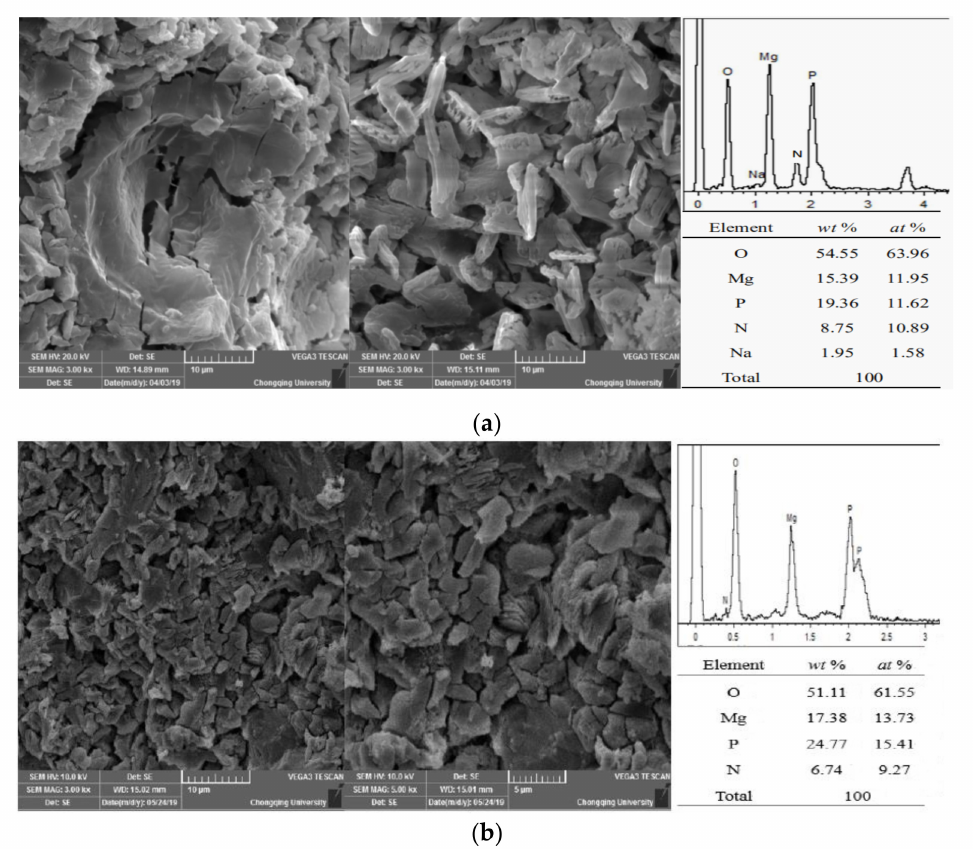
Figure 10. Scanning electron microscopy (SEM) images of MPC samples (1 day) prepared at di ff erent temperatures: ( a ) (20 ± 2) ◦ C; ( b ) ( − 20 ± 2) ◦